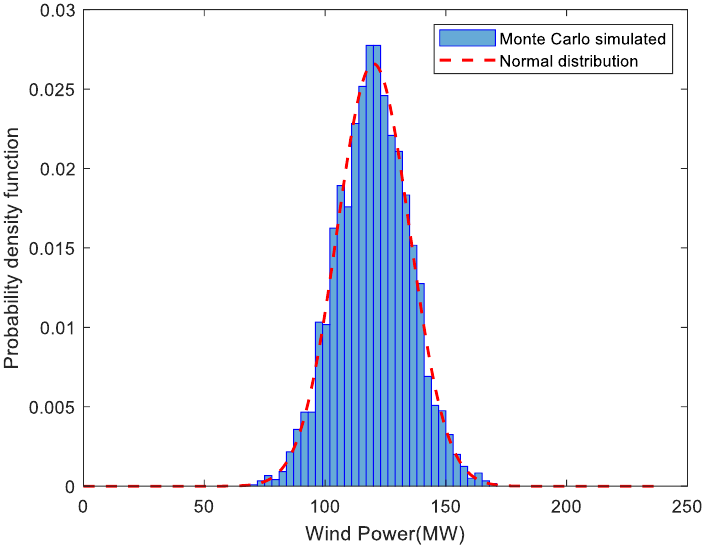
Figure 1. Sample points generated by Monte Carlo simulation.